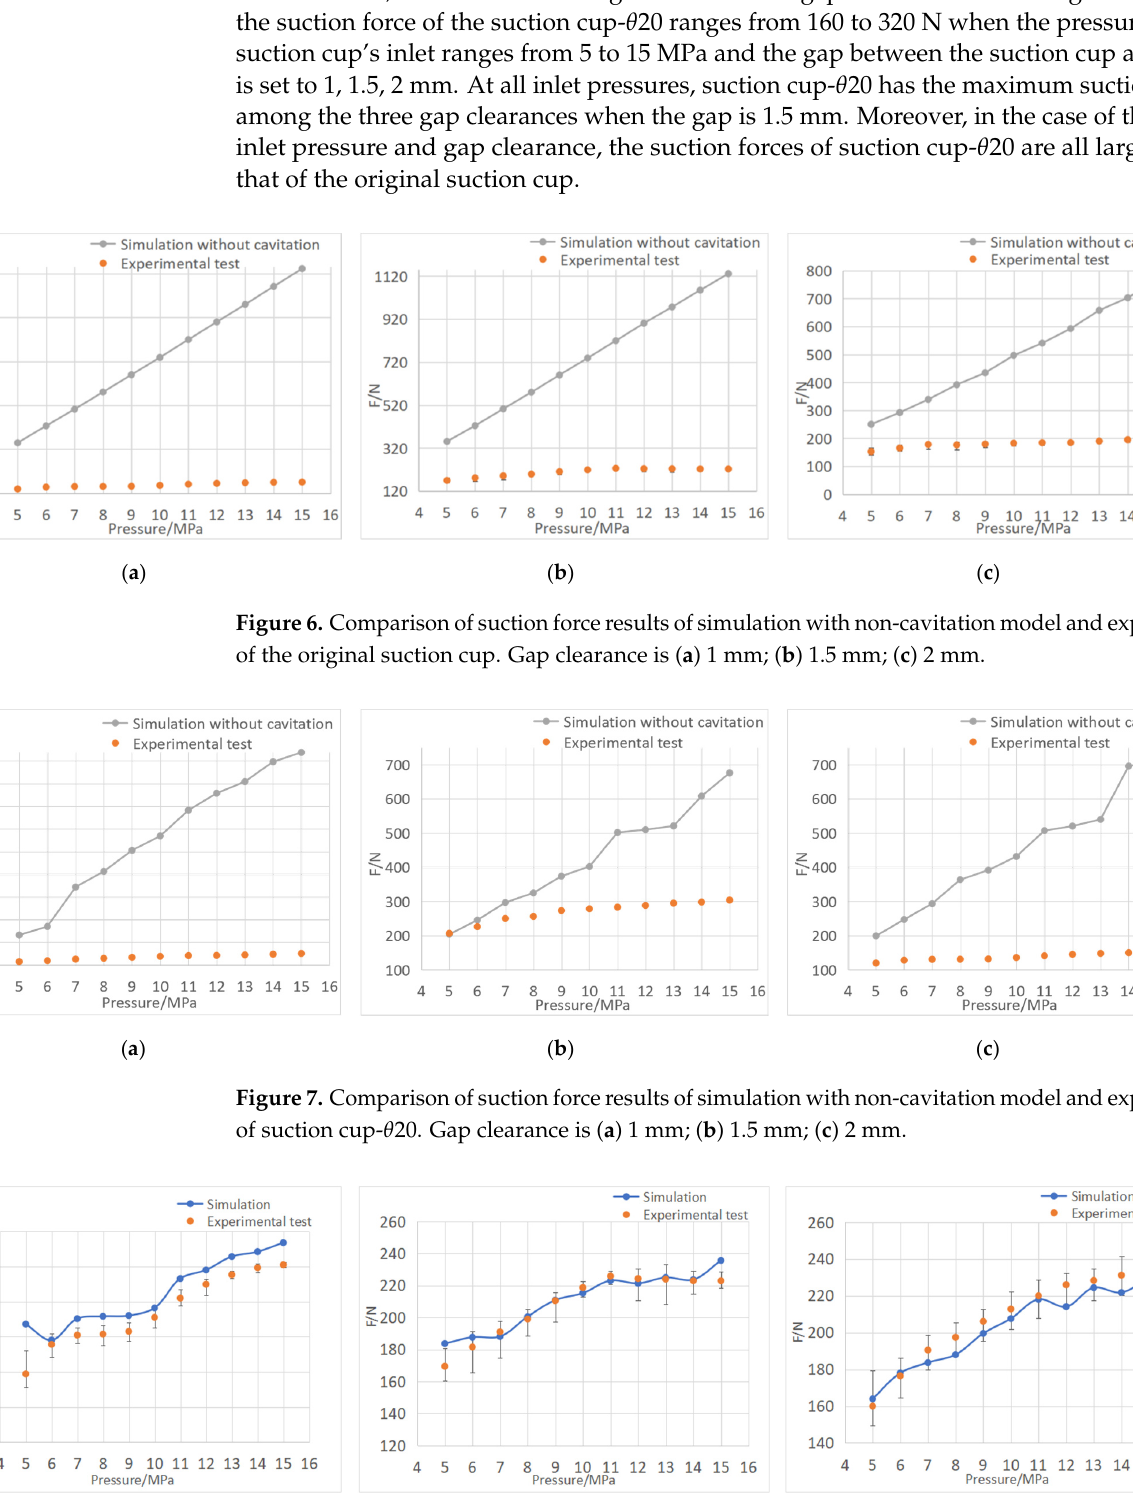
Figure 8. Comparison of suction force results of simulation with cavitation model and experiment of original suction cup. Gap clearance is ( a ) 1 mm; ( b ) 1.5 mm; ( c ) 2 mm.